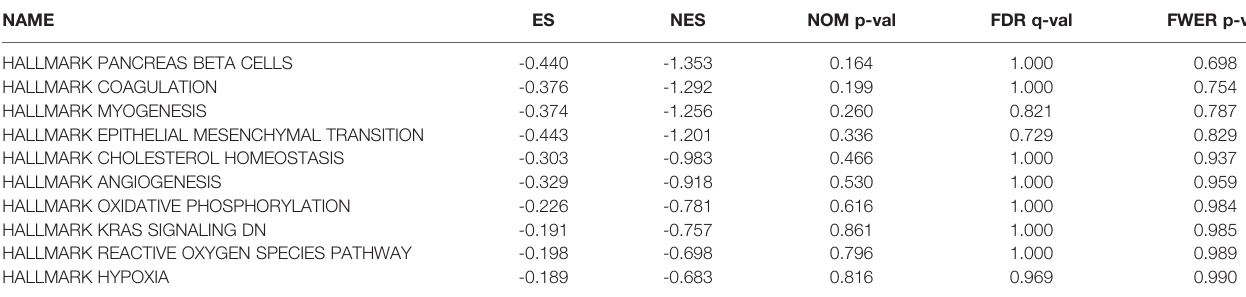
TABLE 3 | HALLMARK enrichment analysis (Top 10).